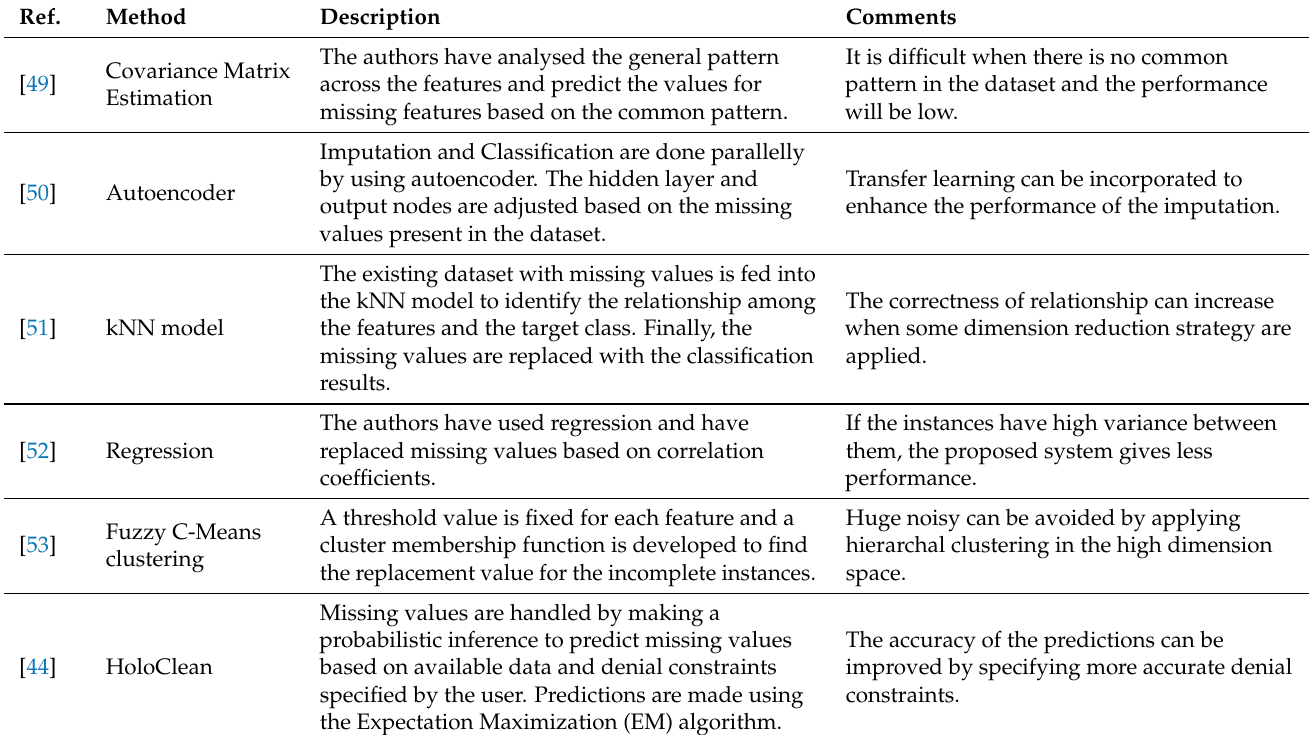
Table 1. Comparison of few works in missing value